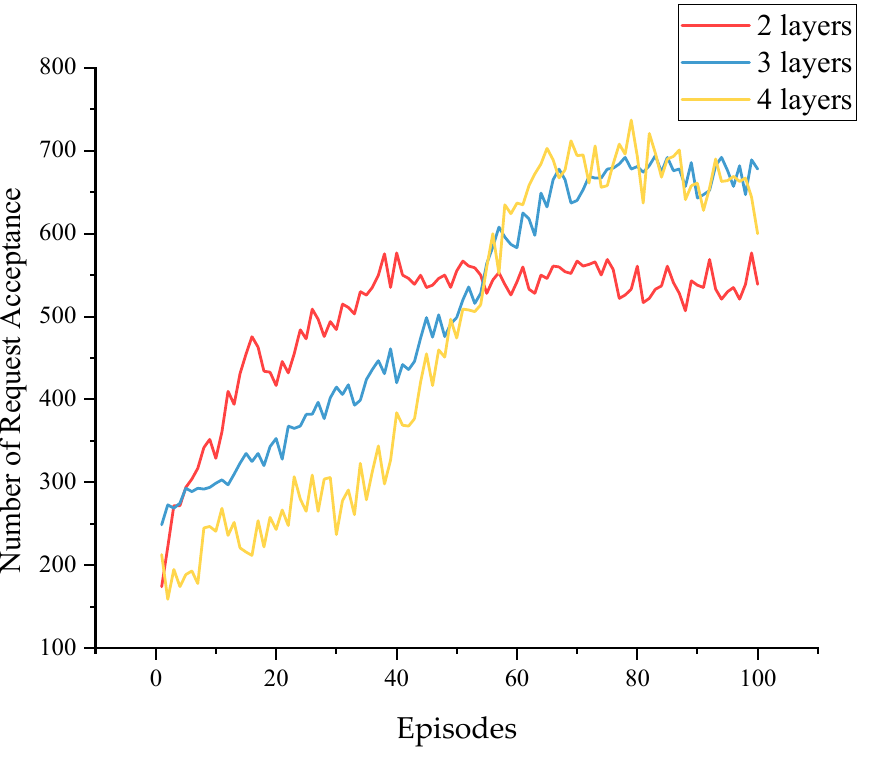
Figure 9. The training process varies with the number of hidden layers. Table 3. Performance of DQN with different numbers of hidden layers. Number of Hidden Layers Request Acceptance